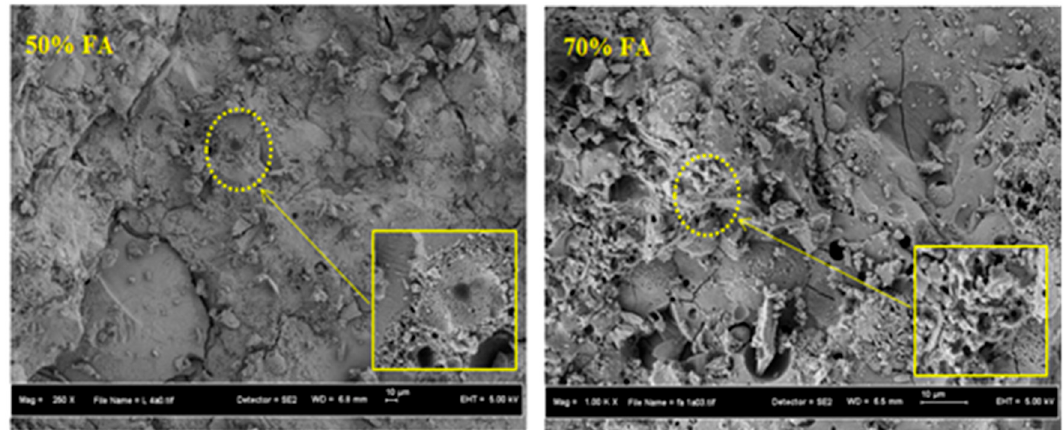
Figure 8. SEM images of AAM designs with different FA contents.